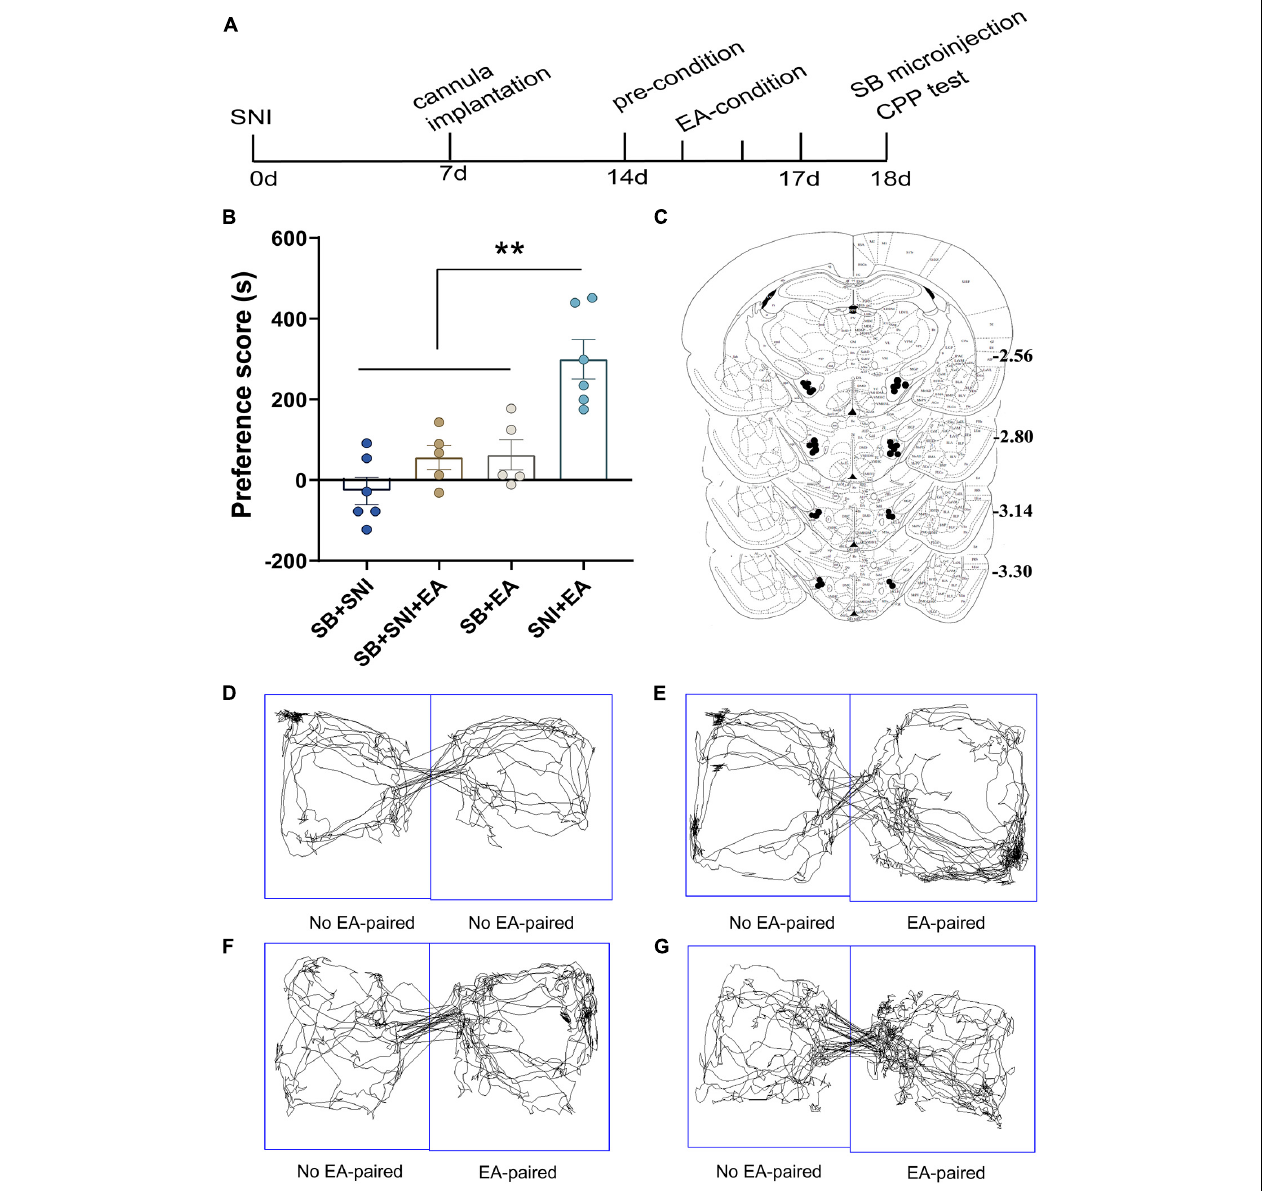
FIGURE 4 | Microinjection of orexin antagonist SB334867 into the LH can significantly attenuate EA-induced CPP in SNI rats. (A) A timeline of SNI modeling, EA-induced CPP, SB microinjection, and CPP test. (B) The preference scores after CPP testing among the different groups. ** p < 0.01 vs. SB + SNI group, SB + SNI + EA group, and SB + EA group. (C) Microinfusion cannula placements. The numbers indicate distance from Bregma in millimeters. Real-time movement traces among the groups during CPP test: (D) SB + SNI group; (E) SB + SNI + EA group; (F) SB + EA group; and (G) SNI + EA